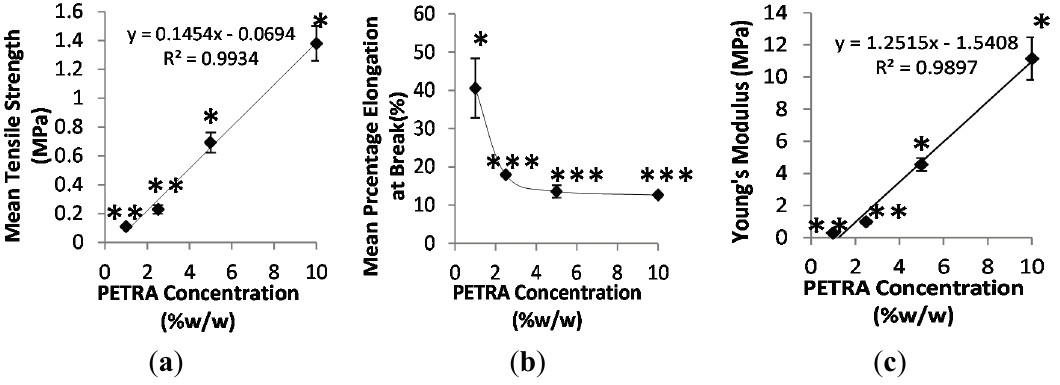
Figure 4. Effect of PETRA concentration on ( a ) tensile strength, ( b ) percentage elongation at break, and ( c ) Young’s modulus. n = 3; * significant differences between all groups; ** significantly different from PETRA concentrations = 5% and 10% w / w ; *** significantly different from PETRA concentration = 1% w / w ; p <